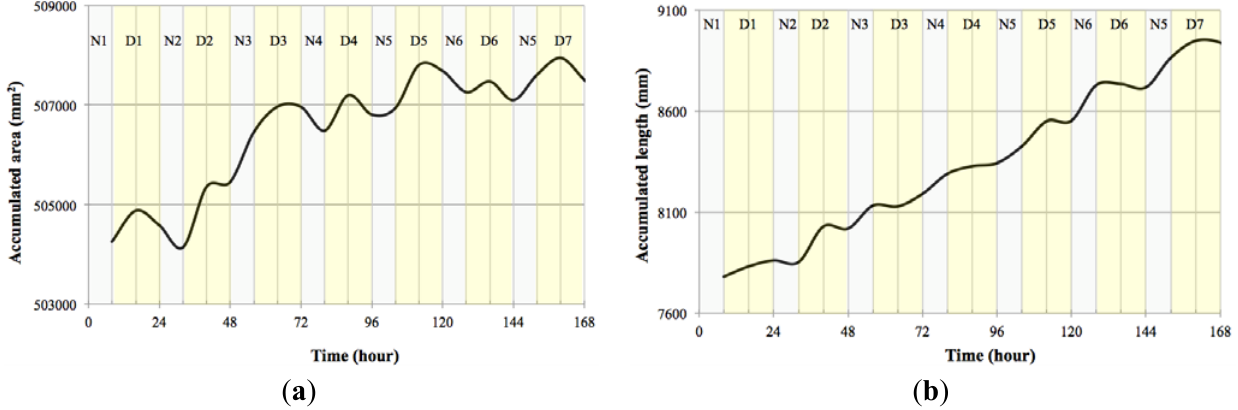
Figure 15. Opuntia . ( a ) Accumulated area; ( b ) Accumulated length.